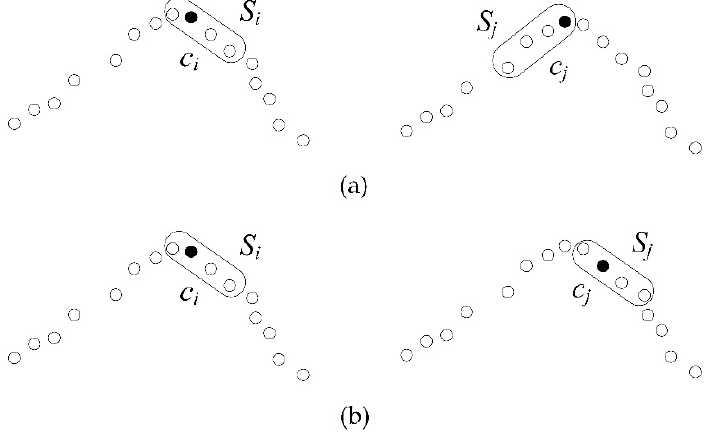
Figure 5. Mutual validation of the connectivity test. The dots represent supervoxels and the rounded rectangles represent support regions. ( a ) Only one side of the region is contained, c j ∈ S i but c i ( b ) The shaded dots are mutually contained, c i ∈ S j and c j ∈ S i . 2.3. Global Optimization of Normal Vectors